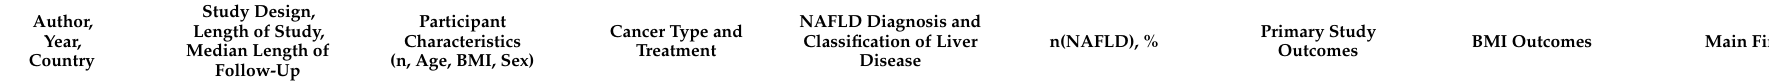
Table 2. Data extraction of the studies (n = 23) included in the systematic